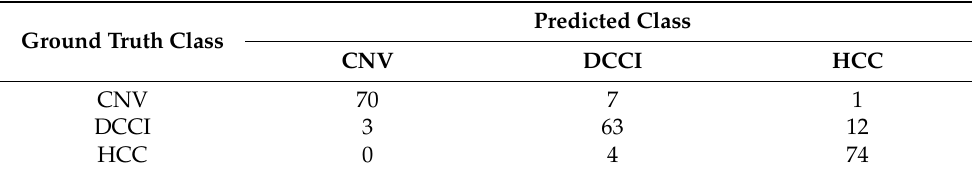
Figure 3. Receiver operating characteristic (ROC) and precision-recall (PRC) curves for the three classes: advanced wet AMD (CNV), intermediate AMD (drusen/CCI: choriocapillaris impairment), no AMD (healthy choriocapillaris). Area under the curve (AUC) values for each class. Table 2. Confusion matrix of the modified VGG19 prediction on a balanced test dataset of 234 OCTA images (78 images for each class). CNV: choroidal neovascularization, DCCI: drusen/choriocapillaris impairment, HCC: healthy choriocapillaris.